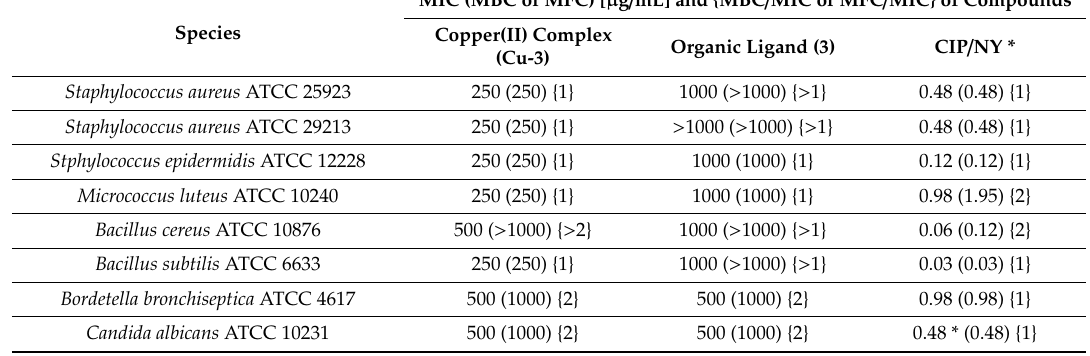
Table 2. The activity data of both compounds: organic ligand ( 3 ) and copper(II) complex ( Cu-3 ) towards some of the reference microorganisms.